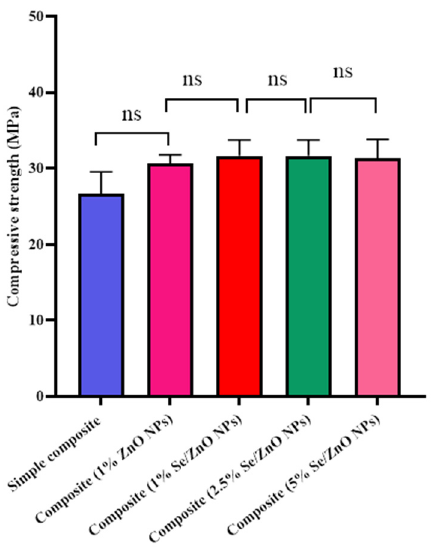
Figure 8. Mechanical strength not affecting by increasing the concentration. ns= not